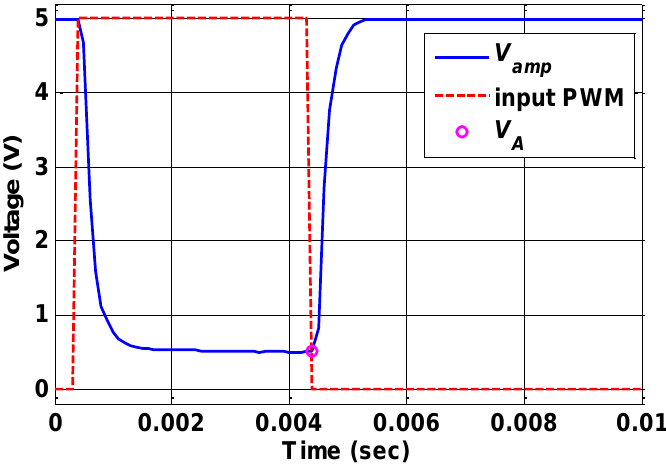
(blue solid line), input PWM (red dashed line) and V amp